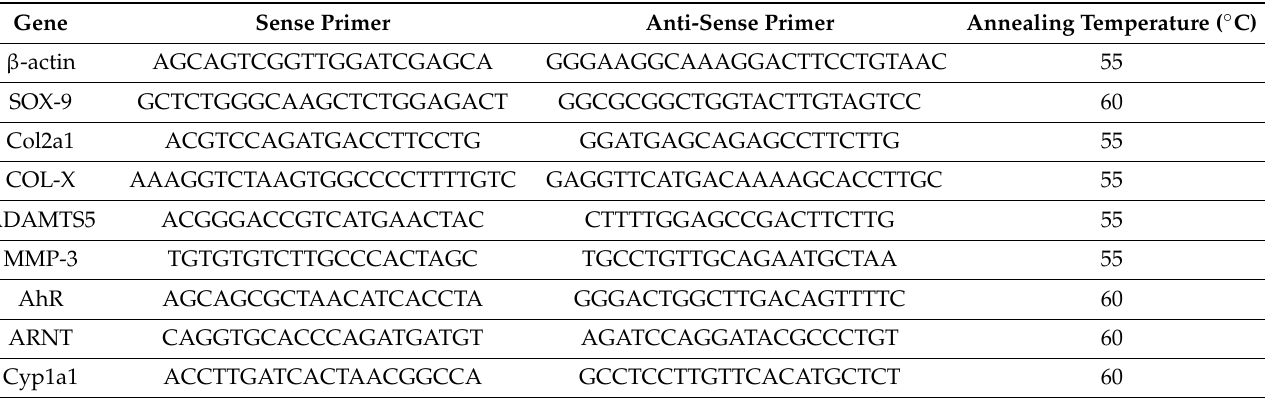
Table 1. PCR primer sequences used for quantitative gene expression